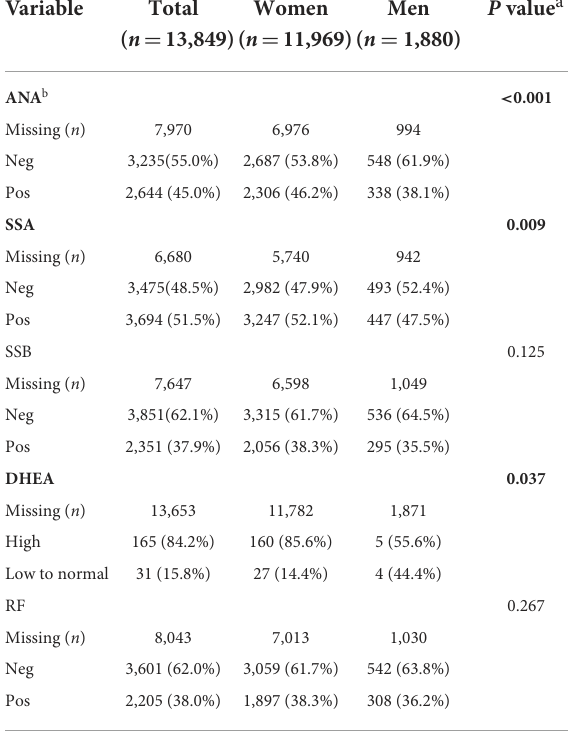
TABLE 3 Autoantibodies and DHEA in women with Sjögren’s disease compared to men.